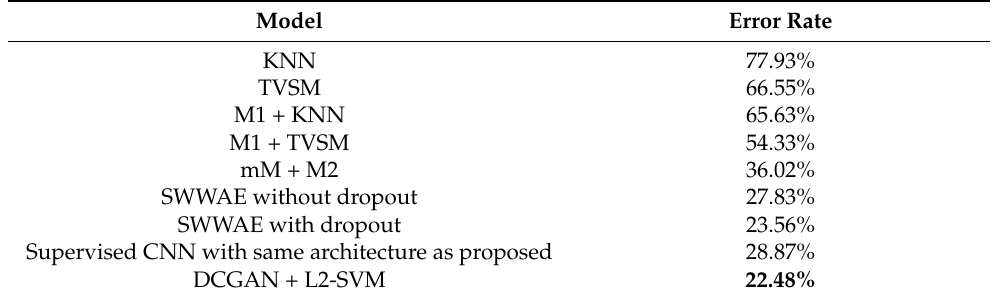
Table 6. Results based on classification of SVHN digits where GANs are used as feature extractors